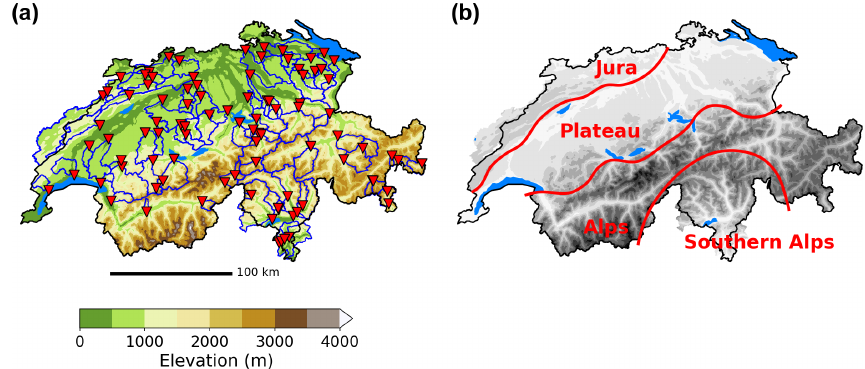
Figure 1. (a) Topography of Switzerland (shading, with major lakes shown in light blue) and gauged catchments used in this study (catchment boundary: blue lines; catchment gauge location: red triangles). The thick black line indicates the Swiss border. (b) Switzerland’s topography (shaded) and major climate and hydrological regions